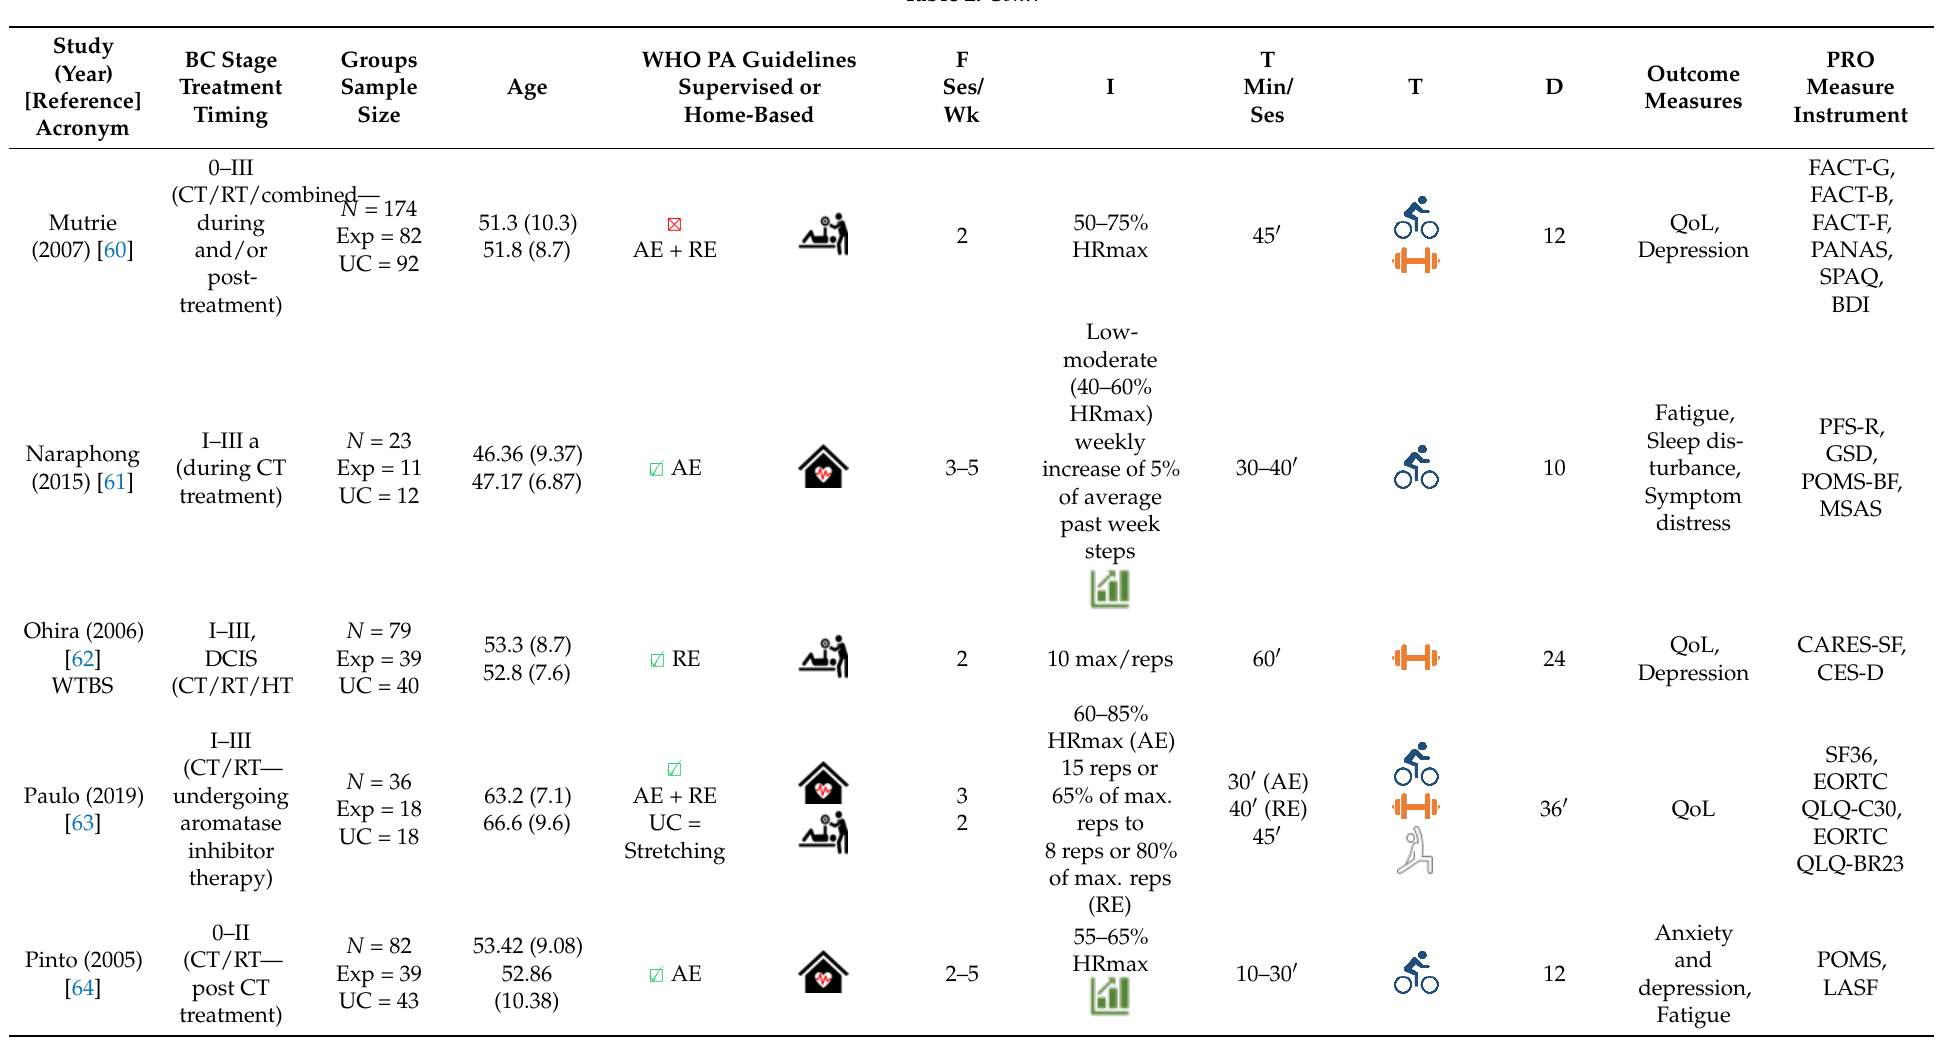
Frequency, Intensity, Time and Type (FITT); Duration (D); Patient Reported Outcome (PRO); Exercise intervention group (Exc); Usual care or control group (UC); Aerobic Exercise training (AE); Resistance Exercise training (RE); WHO guidelines of minimum physical activity/exercise recommended ( : accomplished; not accomplished); Chemotherapy (CT); Radiotherapy (RT); Hormonal Therapy (HT); Quality of Life (QoL); ratings of perceived exertion (RPE); moderate to vigorous physical activity (MVPA); Heart Rate Reserve (HRR); Ductal Carcinoma in Situ (DCIS); PRO measures: Beck Depression Inventory (BDI); The Brief Fatigue Inventory (BFI); European Organization for Research and Treatment of Cancer Quality of Life Questionnaire (EORTC QLQ-C30); Finnish modified version of Beck’s 13-item depression scale (RBDI); Functional Assessment of Cancer Therapy, FACT-Anemia (FACT- A); Functional Assessment of Cancer Therapy-Anemia (FACT-An); Breast (FACT-B); Fatigue (FACT-F); General (FACT-G); Functional Assessment of Chronic Illness Therapy (FACIT); questionnaire for fatigue (FACIT-F); Medical Outcomes Study Short Form (MOS SF-36); Piper Fatigue Scale (PFS); Schwartz Cancer Fatigue Scale (SCF); Women’s Health Questionnaire (WHQ); Patient Reported Outcomes Measurement Information System (PROMIS); Body Image Scale (BIS); Happiness Measure (HM); Social Physique Anxiety Scale-7 items (SPAS-7); Memorial Symptom Assessment Scale (MSAS); Fatigue Assessment Questionnaire (FAQ); Hospital Anxiety and Depression Scale (HADS); HADS-Anxiety (HADS-A); HADS-Depres- sion (HADS-D); Pittsburgh Sleep Quality Index (PSQI); Rosenberg Self-Esteem scale (S-ES); Center for Epidemiological Studies Depression Scale (CES-D); Spielberger State Anxiety Inventory (SAI); Physical Function scale (SF-36); World Health Organization Quality of Life-BREF (WHOQOL-BREF); State-Trait Anxiety Inventory, (STAI); STAI-State Anxiety (STAI- YI), Cohen’s 10-item Perceived Stress Scale (10-PSS); Trial Outcome Index-Anemia (TOI-An) subscale and fatigue subscale; Health Related Quality of Life (HRQoL); Profile of Mood States (POMS); Linear analog scale for fatigue (LASF); Cancer Rehabilitation Evaluation System-Short Form (CARES-SF); Body Image and Relationships Scale (BIRS). * Age presented with mean and SD or range where reported.